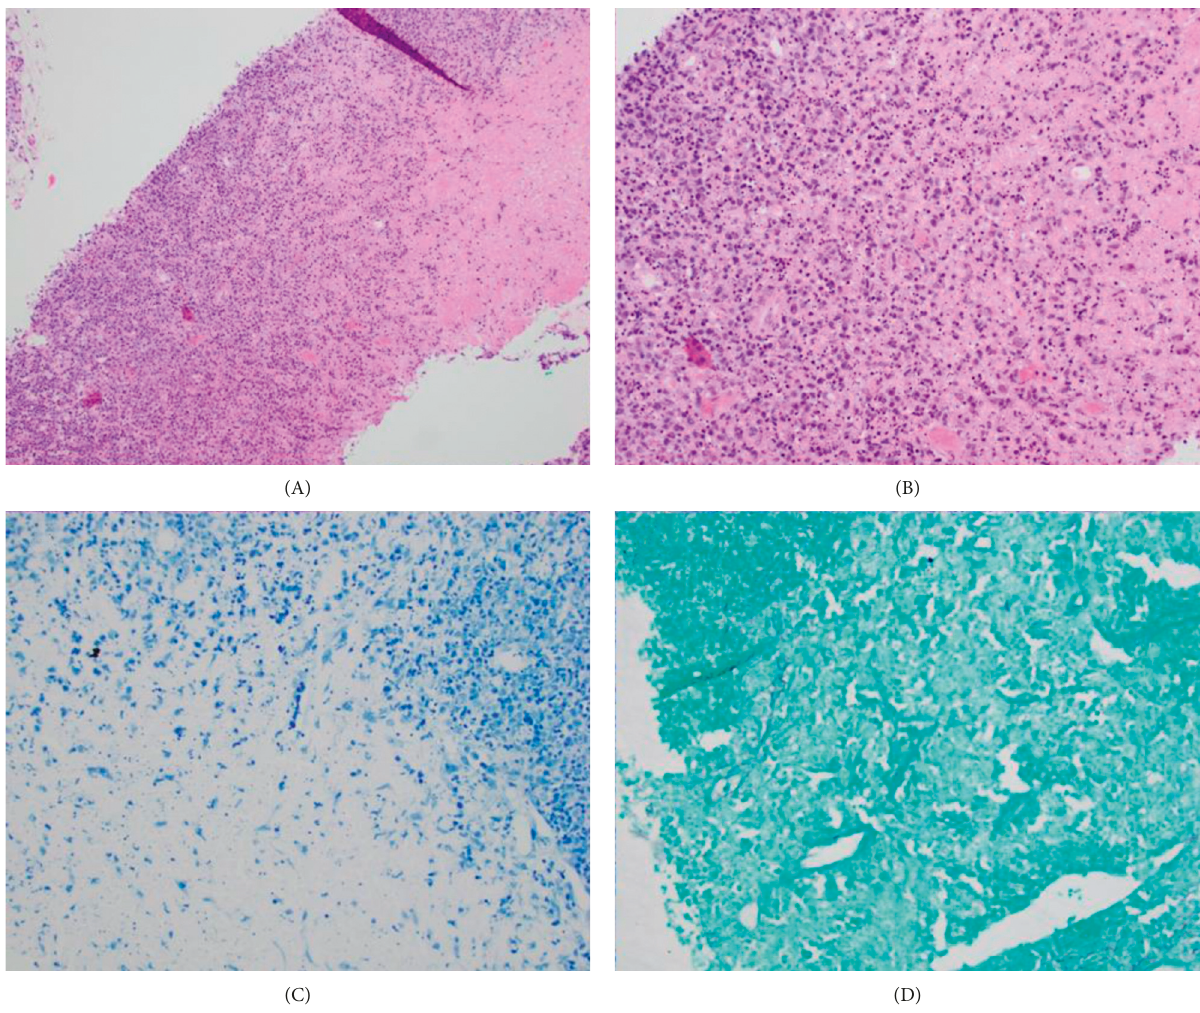
Figure 2: H&E statin ((A) 10x, (B) 20x): area of necrosis with more prominent ongoing necrosis and surrounding proliferation of histocytes and plasmacytoid dendritic cells. (C) Acid-fast bacteria (AFB) stain, 20x. (D) G¨om¨ori methenamine silver stain (GMS) 20x. Negative staining for acid fast bacilli and fungal elements.